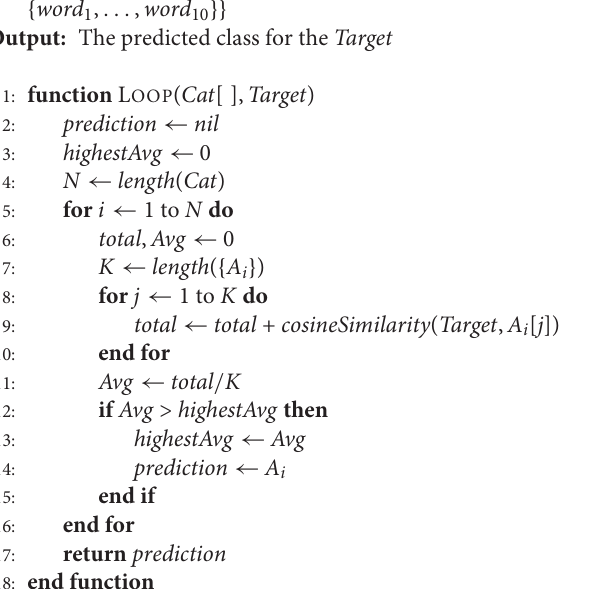
Algorithm 1: Text Classification using AGROVEC and ConceptNet